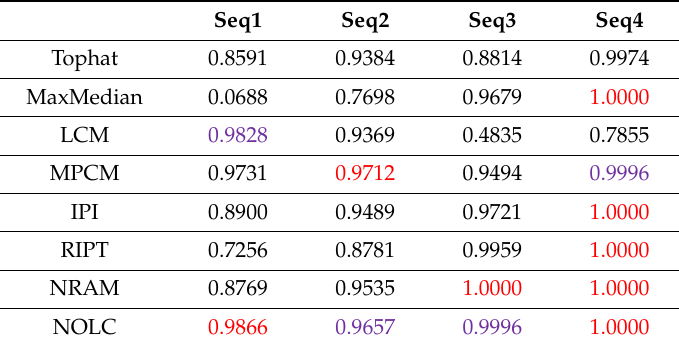
Figure 16. Seven algorithm comparison ROC curves. Table 3. AUC of the ROC curves in Figure 14.